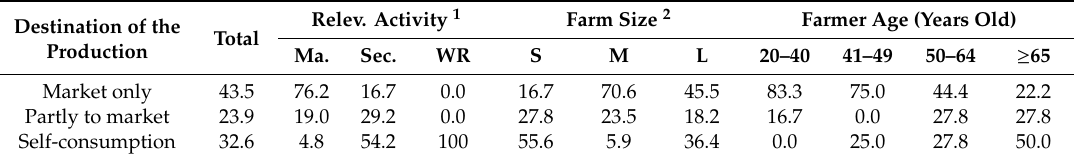
Table 3. Relative frequency (%) of production destination by relevance of agricultural activity, farm size, and age of respondents.